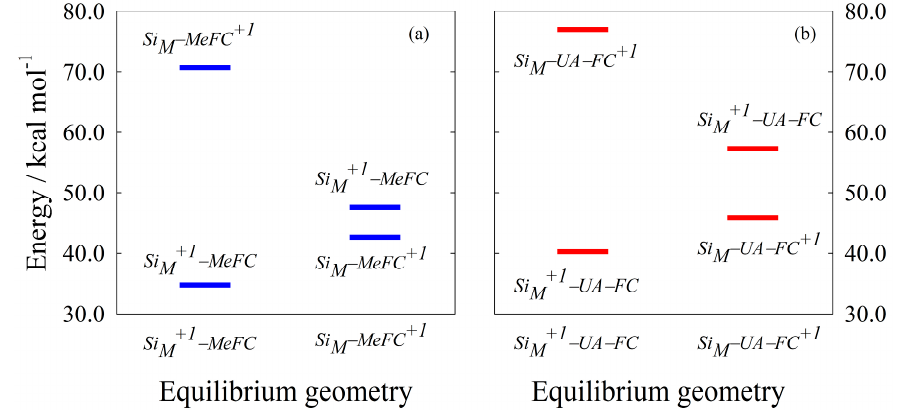
Figure 2. CDFT energies as a function of the initial and final equilibrium geometries. ( a ) Si M –Me–FC redox system ( b ) Si M –UA–FC redox system. Energies are scaled with respect to the relevant neutral closed shell species. See the text for details.